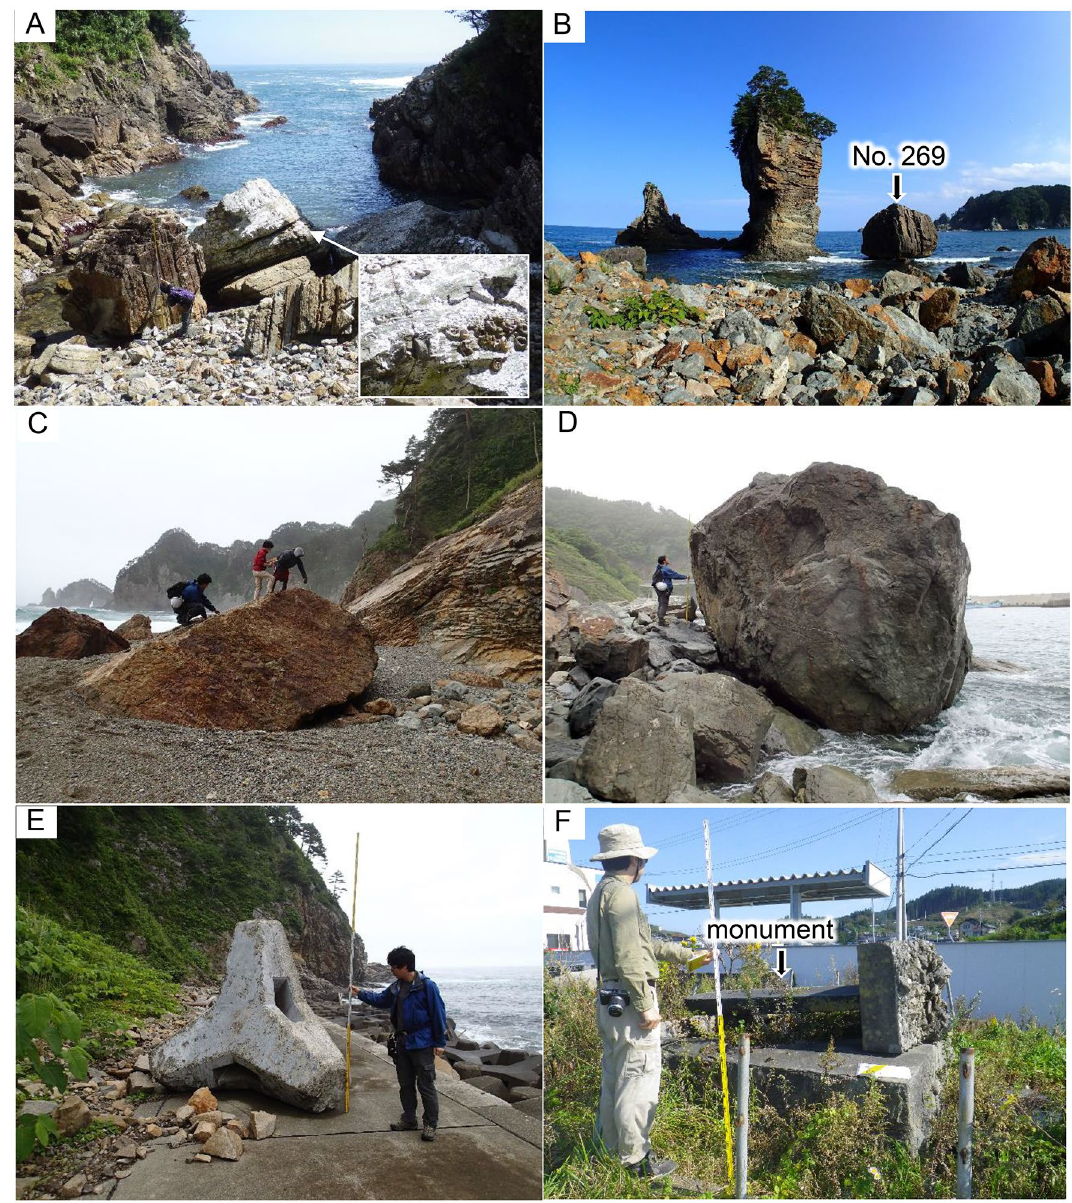
Figure 3. ( A ) Boulder, with remains of worms attached, deposited by the 2011 Tohoku-oki tsunami at Karakuwa Town (No. 272 of the Table in the Supplemental Information), which was studied earlier by Nandasena et al. 6 . ( B ) No. 269 boulder in Fig. 2 at Miyako City, which was not moved by the 2011 tsunami according to satellite image analysis (type 1 boulder). The boulder height is 10.4 m as a scale. ( C ) Boulder (No. 12) partially buried into the sand at Tanohata Village (type 2 boulder). ( D ) Boulder (No. 22) locked by other boulders at Miyako City (type 2 boulder). ( E ) Wave-dissipating block (No. 9) deposited on the road at Fudai Village. ( F ) Overturned tsunami monument (Iwate219) at Rikuzentakata